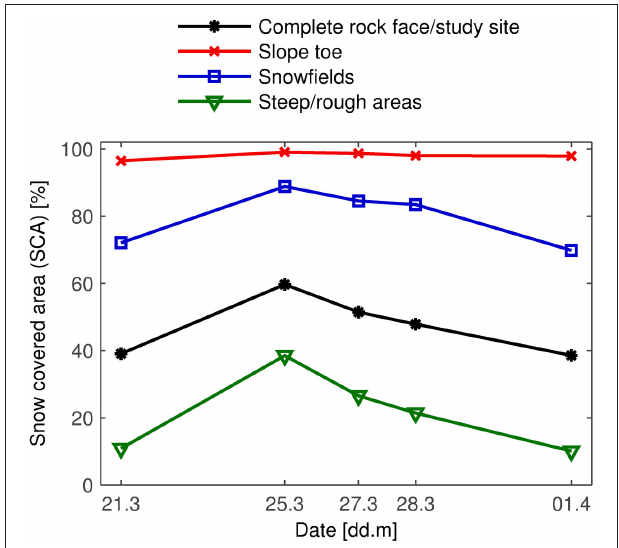
FIGURE 7 | Evolution of snow covered area (SCA) in the rock face. After a marked increase during the snowfall, SCA reattains pre-snowfall values a week later. Note the strong decrease in the “steep/rough” areas compared to the “snowfields” between 25 and 28 March.